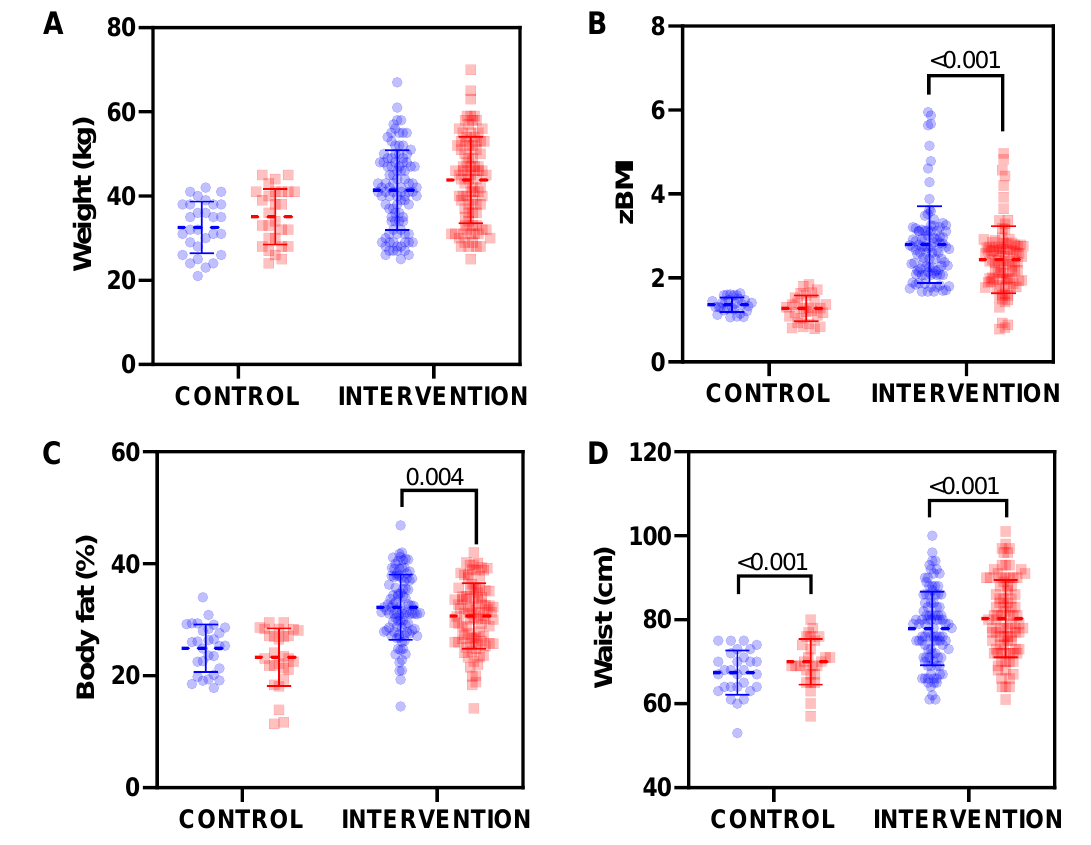
Figure 1. Changes in ( A ) weight, ( B ) BMI z-score (zBMI), ( C ) body fat percentage and ( D ) waist from baseline (blue dots) to the end of the intervention (red dots). The dashed line represents mean value and solid lines represent standard deviation. Statistically significant differences were analysed by a repeated measures ANOVA.